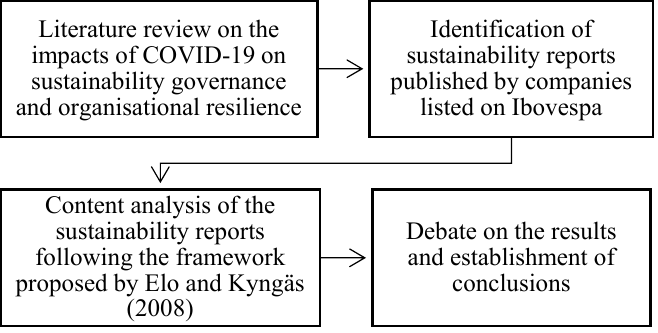
Figure 1. Research steps (Source: Authors).